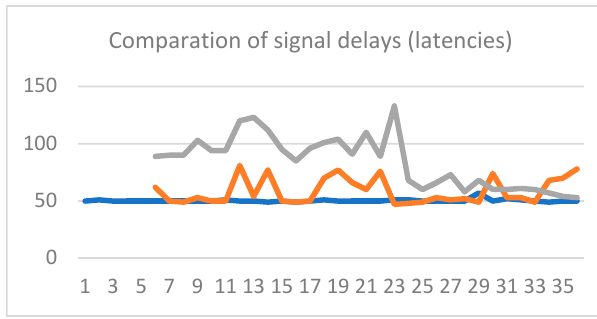
Figure A7. Comparison of delay of signals (MDMG).